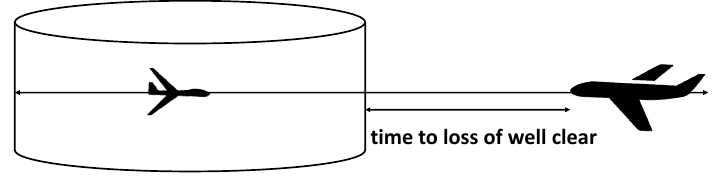
Figure 4. Time to loss of well clear in horizontal direction.